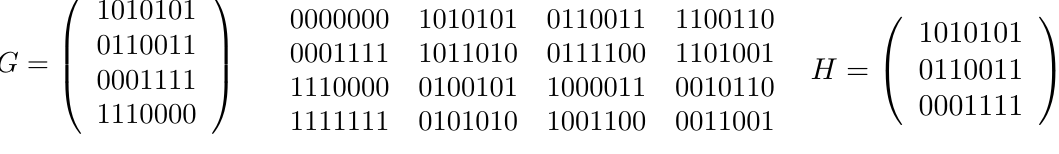
obtained, and so on. At the right there is a parity matrix H